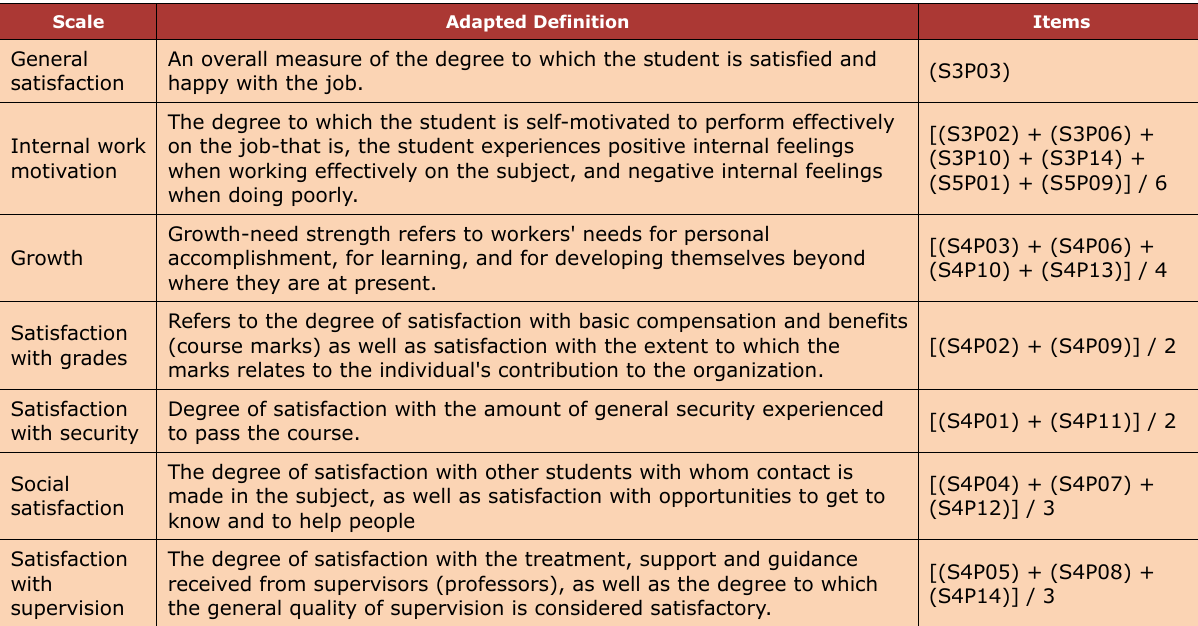
Table 2. Scales definitions of the JDS university student questionnaire. Source: (Martínez-Gomez &